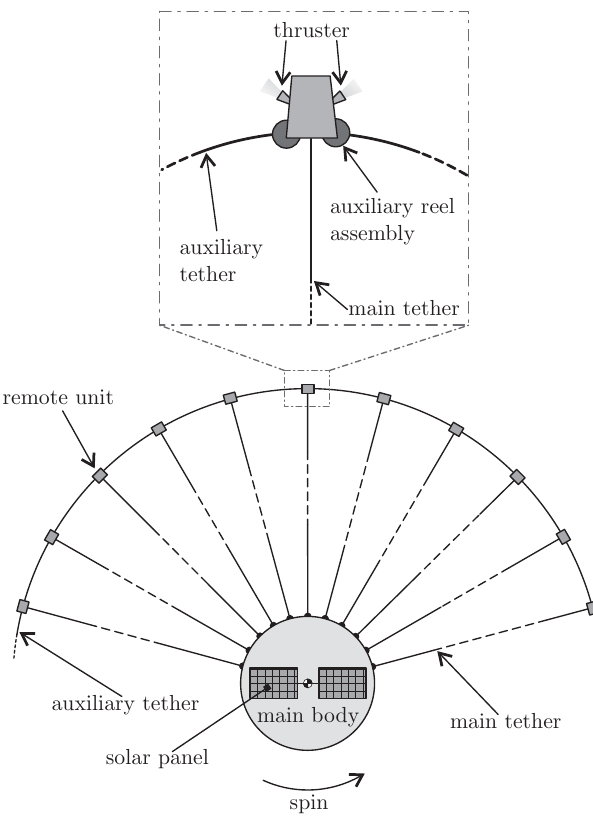
Fig. 2. Schematic view of E-sail with remote unit and auxiliary teth-